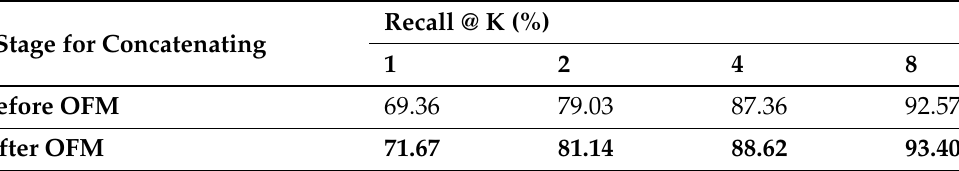
Table 3. This table shows the stage in which the concatenation starts. The row ‘Before OFM’ shows the performance of the model when the concatenation begins before the descriptors are processed by the OFM. In contrast, the row ‘After OFM’ indicates the performance after the descriptors are processed by the OFM. The bold values are the best performances in each recall @